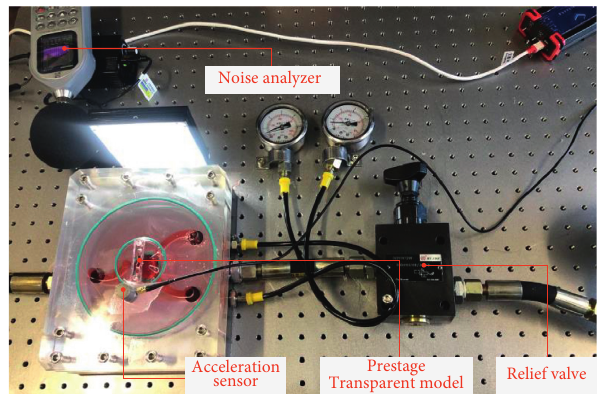
Figure 18: Experimental setup of the vibration and noise